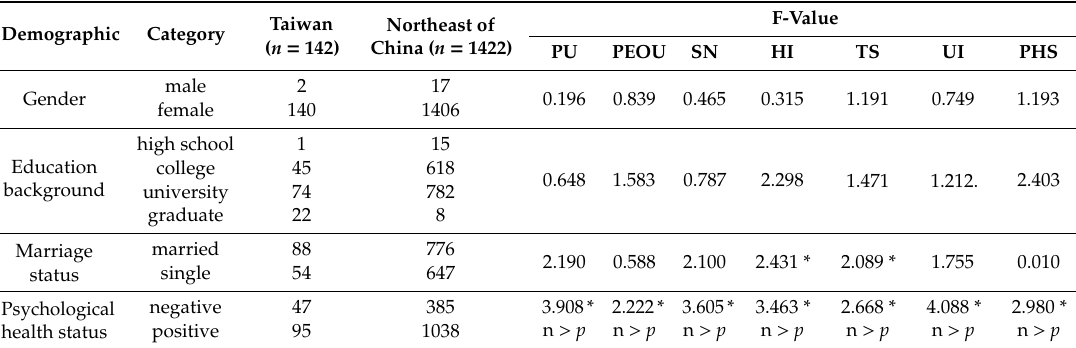
Table 2. Demographic